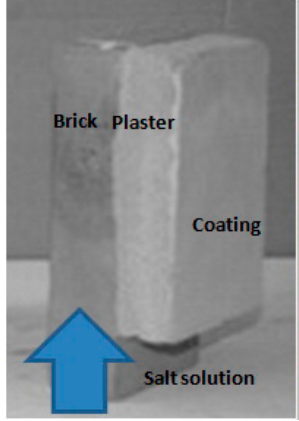
Figure 9. Brick-plaster-coating system.